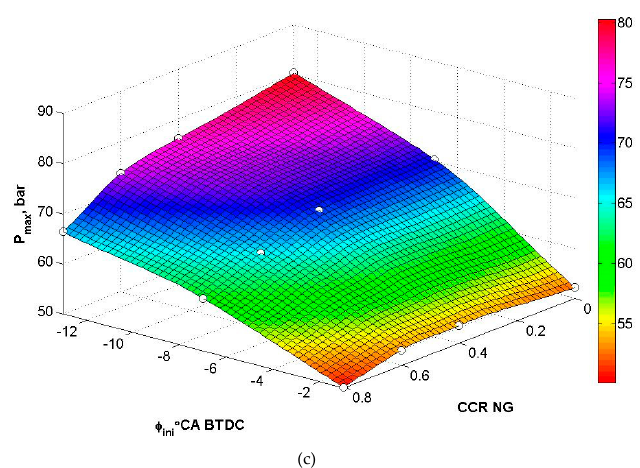
(cid:16) − 1 (cid:17) n = 2000 min : ( a ) HLM;